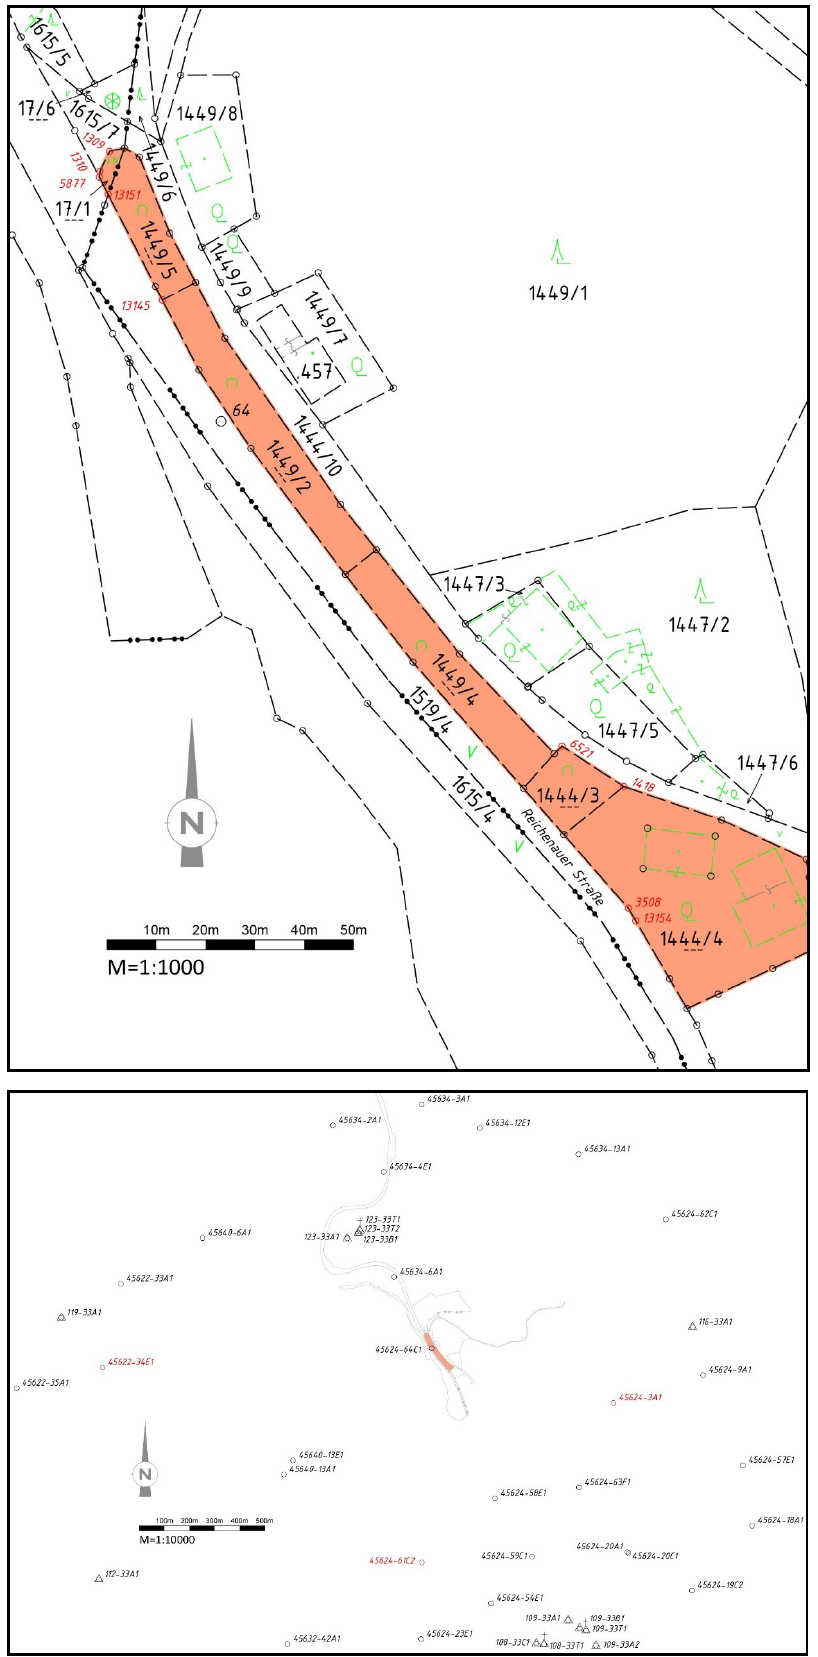
Figure 2. Cadastral map showing the affected parcels ( top ) and overview of the control point network ( bottom ). The control points marked in red do exist but are suspended from use (data: